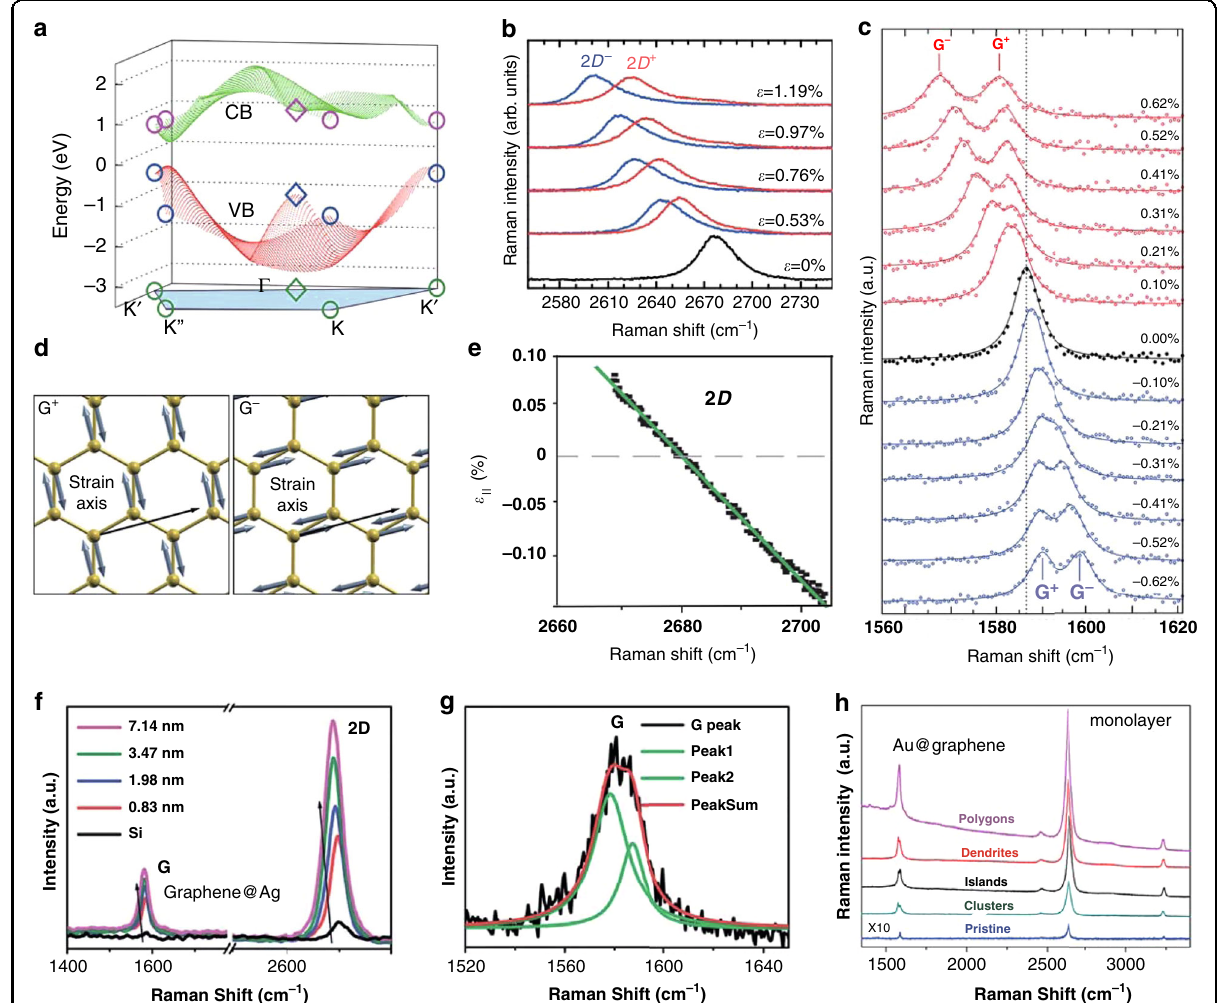
Fig. 5 Gap opening and Raman responses of strained graphene. a Calculated band structure (valence band marked as VB and conduction band marked as CB) of graphene under combined shear and uniaxial strain with ε = 15% (ref. 58 ). b , c Raman spectra of graphene as a function of uniaxial strain, showing the evolution of the 2D ( b ) 30 and G ( c ) bands 111 . d Eigenvectors of G + and G − modes for strained graphene calculated by density- functional perturbation theory, where G − is polarized along the strain axis 109 . e Linear relationship between the 2D peak position and the biaxial strain in graphene 97 . f Raman spectra of graphene on Ag thin fi lms, showing redshifts of both the G and 2D peaks increasing surface roughness 113 . g Splitting of the G peak of graphene on a rough Ag fi lm (3.47 nm surface roughness) 113 . h Raman spectra of pristine graphene and graphene modi fi ed by four Au nanostructures 108 . Reprinted a with permission from ref. 58 . Copyright (2010) by the American Physical Society. Reprinted b with permission from ref. 30 . Copyright (2011) by the American Physical Society. Adapted c with permission from ref. 111 . Copyright (2010) from American Chemical Society. Reprinted d with permission from ref. 109 . Copyright (2009) by the American Physical Society. Adapted e with permission from ref. 97 . Copyright (2010) from American Chemical Society. Reproduced f – g from ref. 113 with permission from The Royal Society of Chemistry. Reprinted h from ref. 108 . Copyright (2013) with permission from